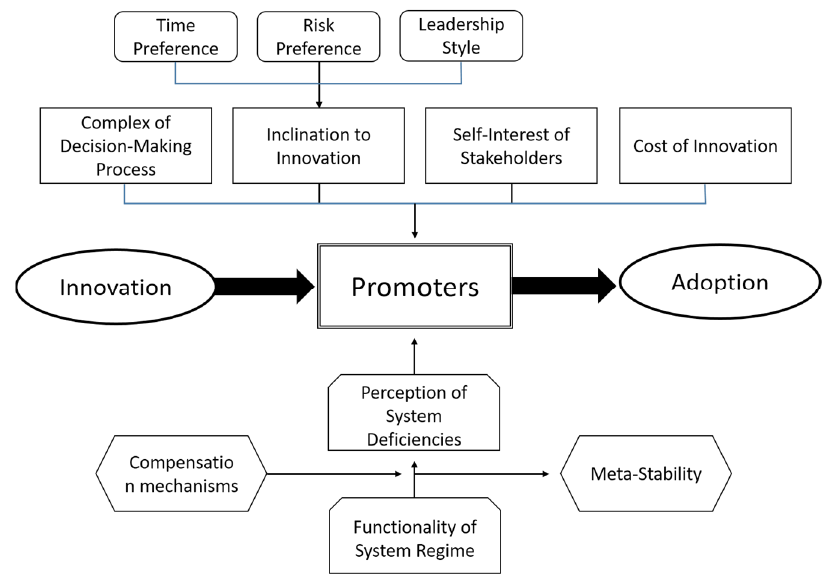
Figure 3. Model of Adoption of a Health Care Innovation.